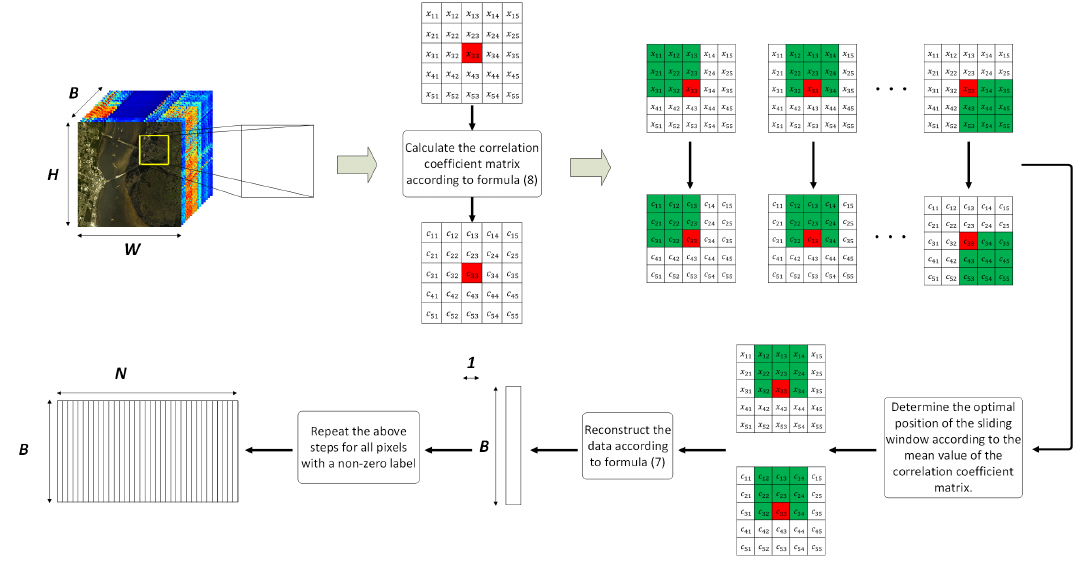
Figure 2. An example of the general flow of the NSW